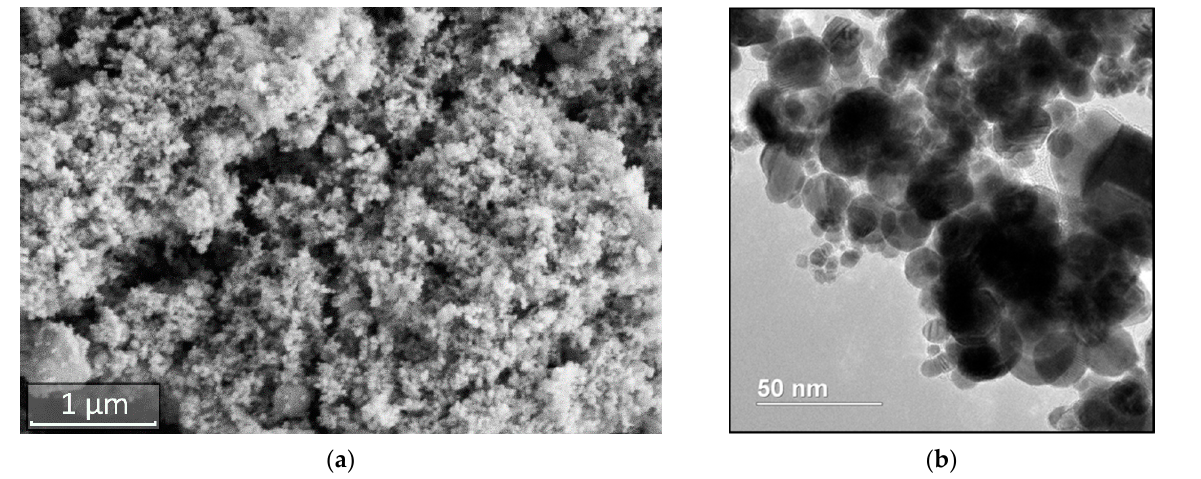
Figure 1. SEM ( a ) и TEM ( b ) images of W-C-Co nanopowder. Phase composition of the obtained W-C-Co system nanopowder containing 4.7 wt.% the presence of WC and W phases (Figure 2a).